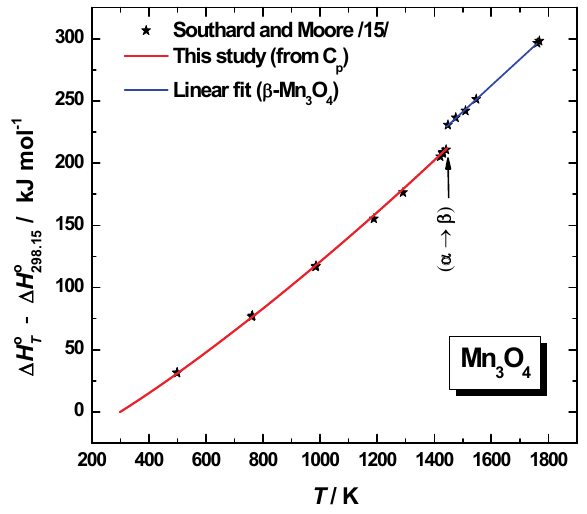
Figure 6. Comparison of the enthalpy increment / of ˛ -Mn 3 O 4 reported by Southard and .H 0 (cid:4) H 0 298:15 T Moore [15] with values calculated from C 0 this study as a function of temperature. Experimental data for ˇ -Mn 3 O 4 can be represented by a linear